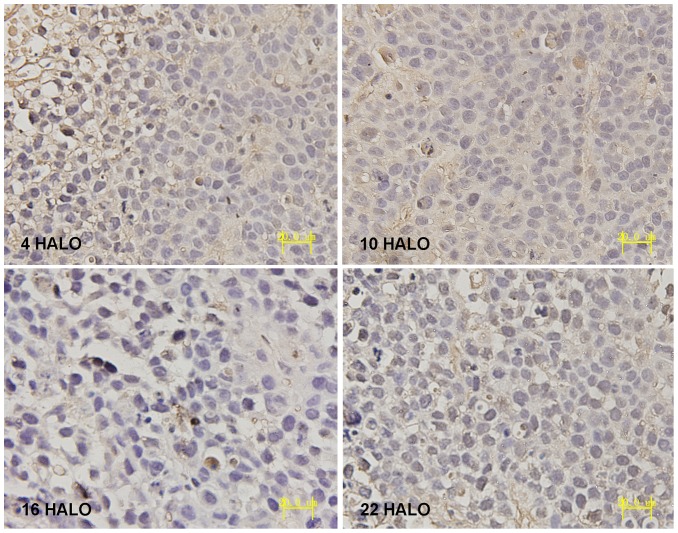
Immunohistochemical staining of MMP-2 protein expression in tumors of tumor bearing mice.Minimum MMP-2 staining was seen in tumors resected at 16 HALO, while tumors resected at 10 HALO showed the highest MMP-2 staining (magnification, ×400).